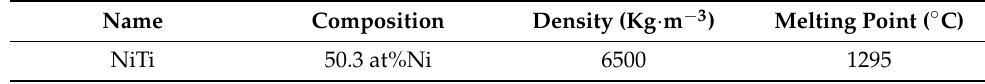
Table 1. Material properties of NiTi wires.